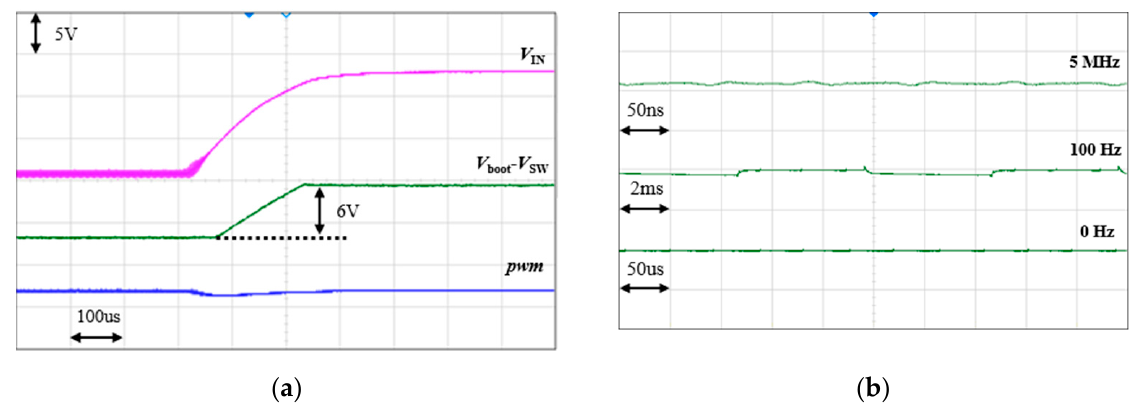
Figure 12. Measured bootstrap circuit (external C boot = 1 µF) ( a ) power on and stable state, and ( b ) bootstrap voltage at pwm = 0 Hz, 1 MHz, and 5 MHz.